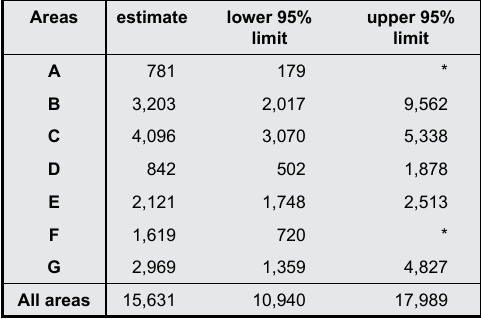
Table 3. Point estimates and confidence intervals for the number of grey seals of both sexes and all ages using the summer haul- outs in areas A to G of the Baltic in year 2000.